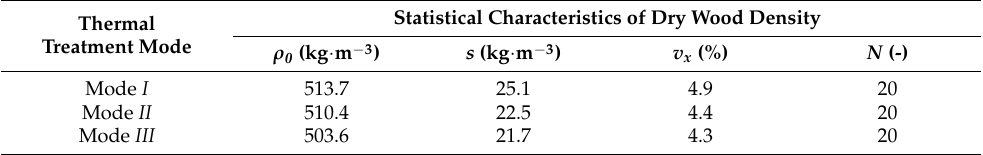
Table 3. Average density values of dry thermally treated alder